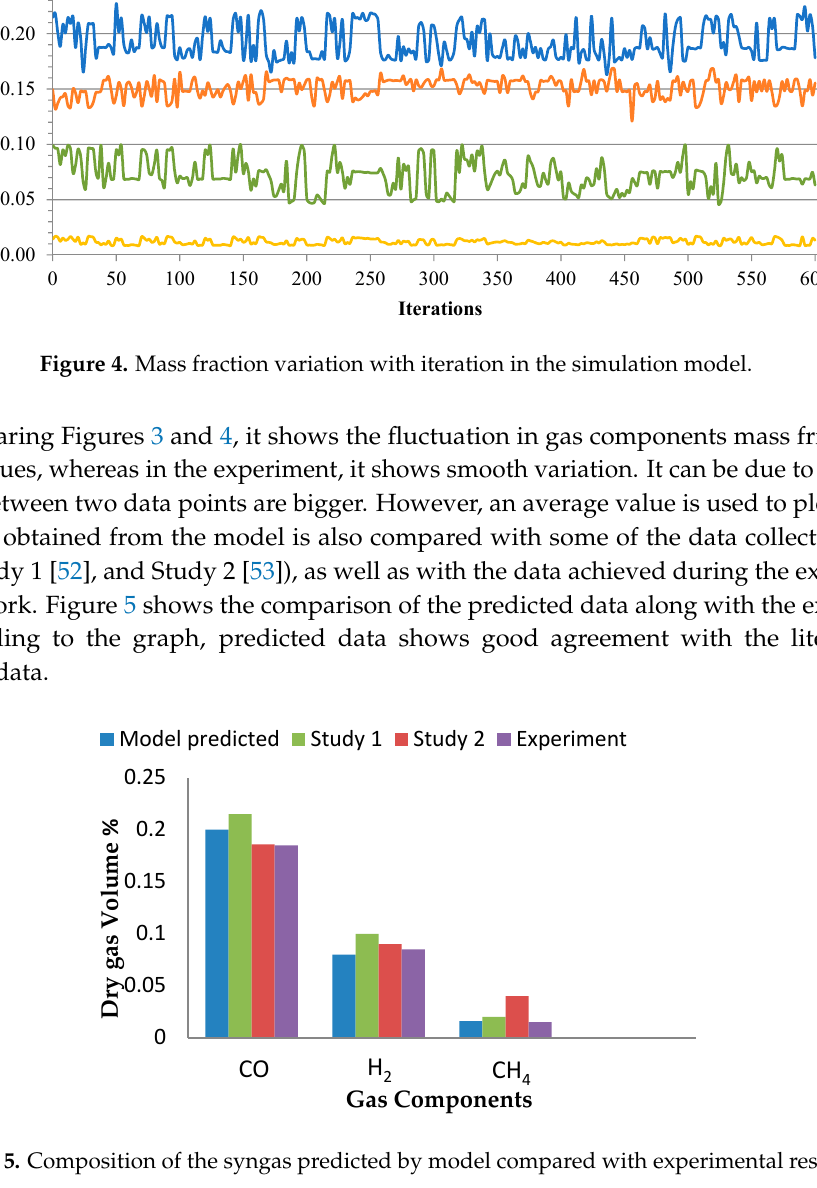
Figure 5 . Composition of the syngas predicted by model compared with experimental results. Figure 5. Composition of the syngas predicted by model compared with experimental